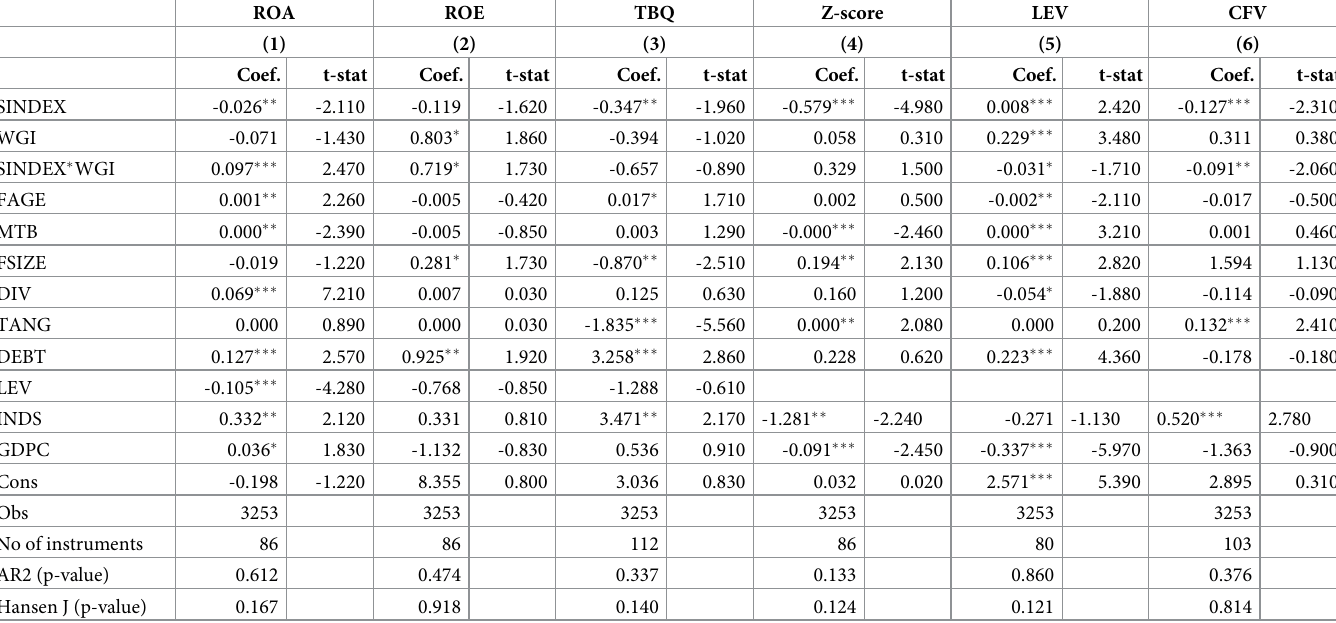
Table 9. Robustness test using system GMM results and alternative measure of COVID-19